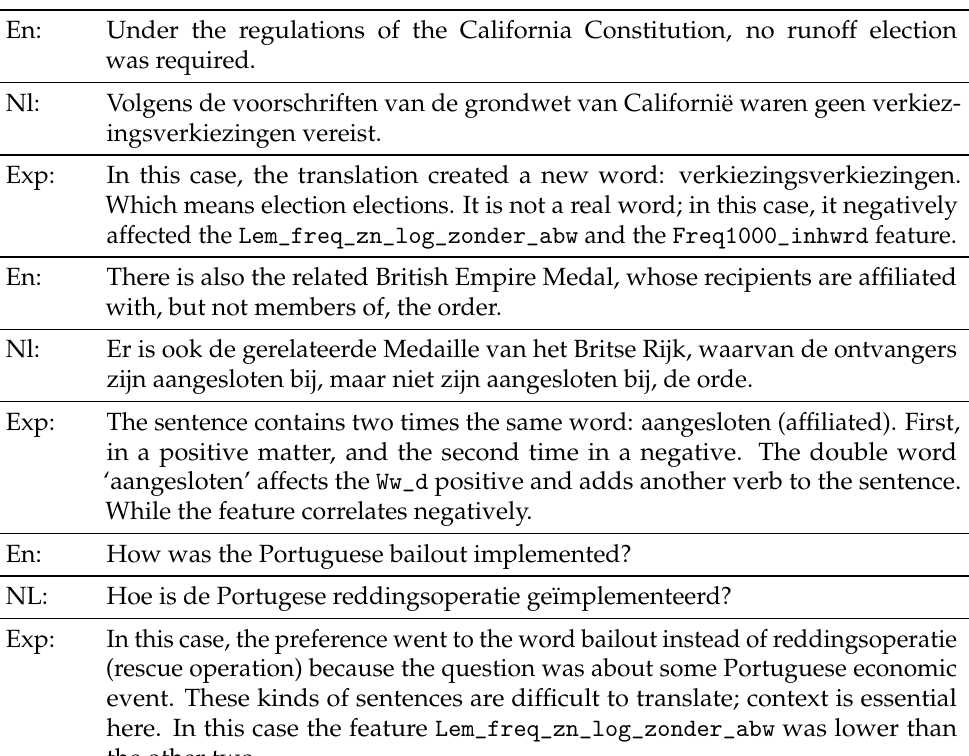
Figure 4. Regression plots. For each feature, it is hard to distinguish between the best scale and the other scale. Table 4. Examples of when Google was classified as the